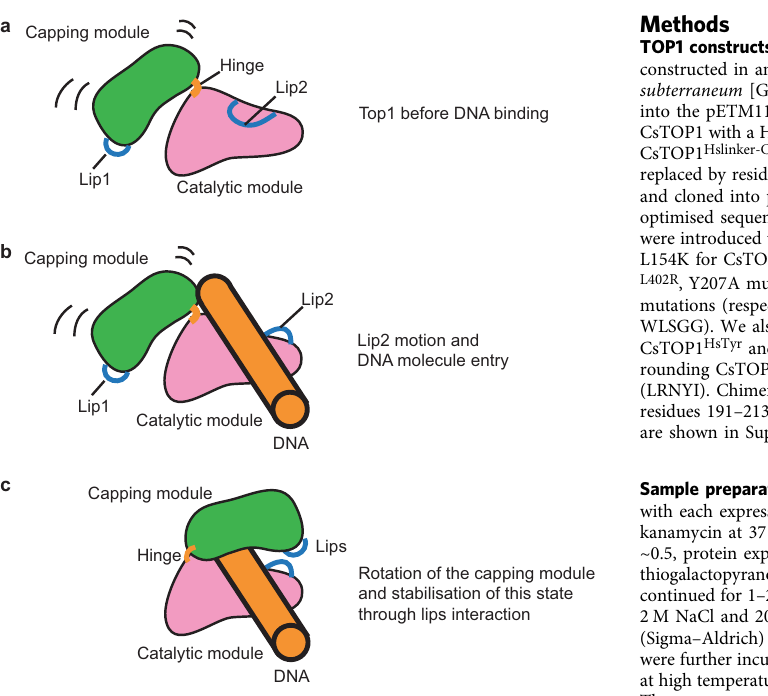
Fig. 8 Proposed model of DNA entry inside the TOP1 catalytic site. a In its apo-state, the CAP domain (green) and the CAT, Linker, C-ter domains (pink) can rotate. Lip2 is interacting with the DNA-binding region of the catalytic module. b After the displacement of the Lip2, one DNA molecule can enter the TOP1 catalytic site. c The Capping module rotates to trap DNA in the catalytic site. This rotation relies on the hinge and one conserved tyrosine from the CAP domain. The interaction between the two lips stabilizes the closed